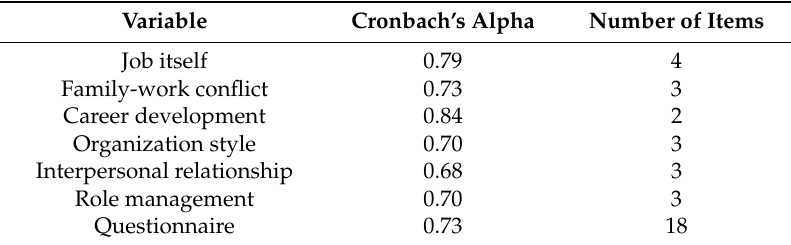
Table 5. Job stress scale reliability statistics.